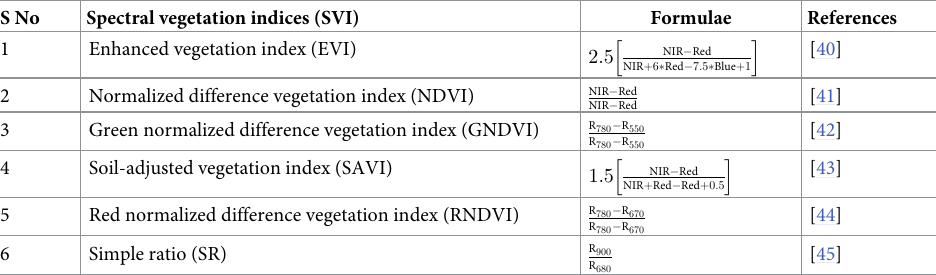
Table 1. Vegetation indices (SVI) employed in the